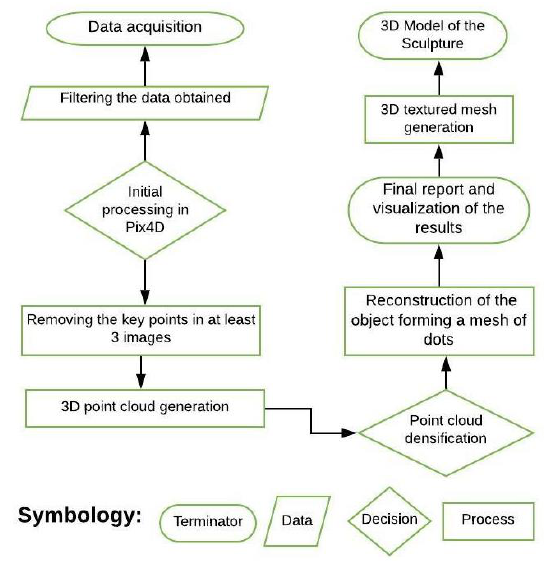
Figure 3. Methodology used for the 3D Model of the Replica Sculpture San Agustín